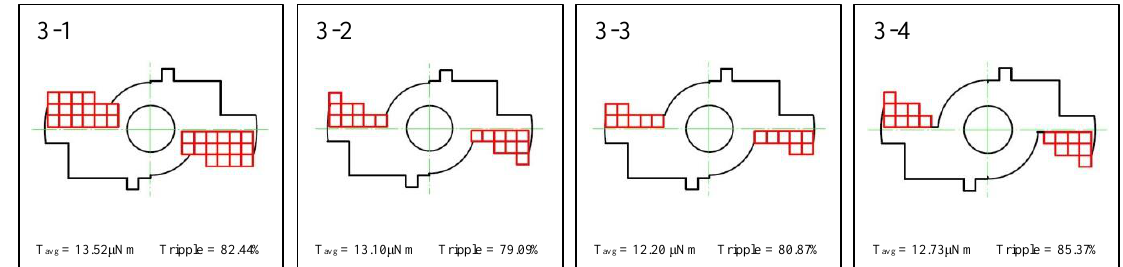
Figure 7. Step 3: Design process of the rotor magnetic poles for quadrant 2 and 4.